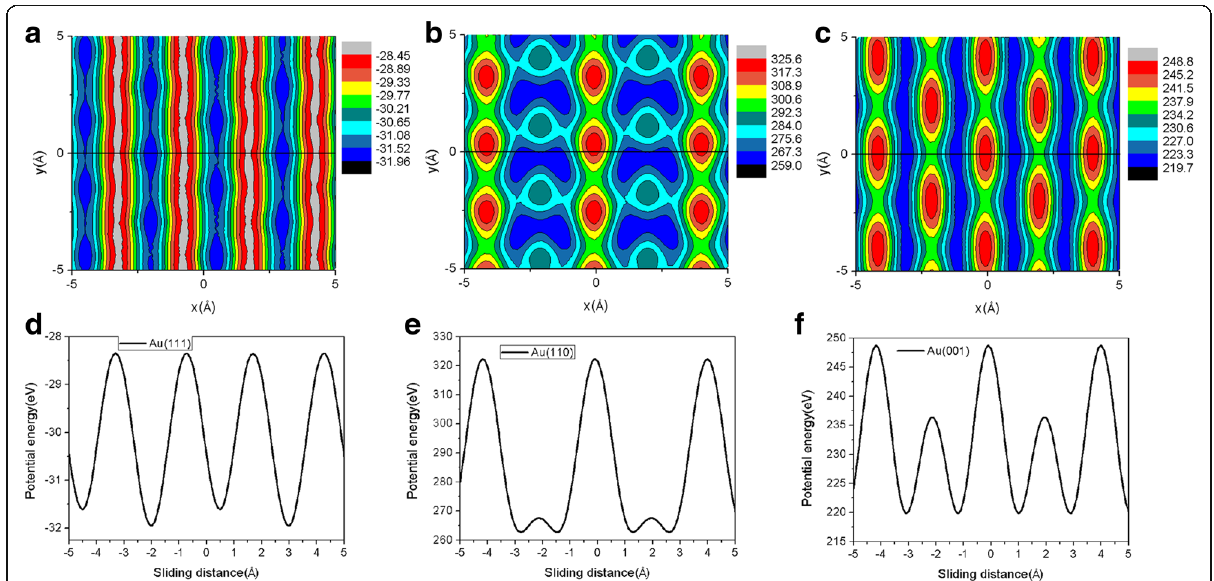
Fig. 9 Contour maps of the potential energy for the Au(111), Au(110), and Au(001) surface at L = 120 nN are shown in a – c , respectively. The 5.8-nm square graphene flake is adopted. In a – c , a black solid line ( y =0) on the maps is used to show the sliding path of the flake. The graphene- gold interaction potential energy along the sliding path for the Au(111), Au(110), and Au(001) surface is also plotted in d – f , respectively. The unit of the potential energy is eV. The average height of the flake at L = 120 nN for the Au(111), Au(110), and Au(001) surface is 2.36 Å, 2.1 Å, and 2.17 Å, respectively